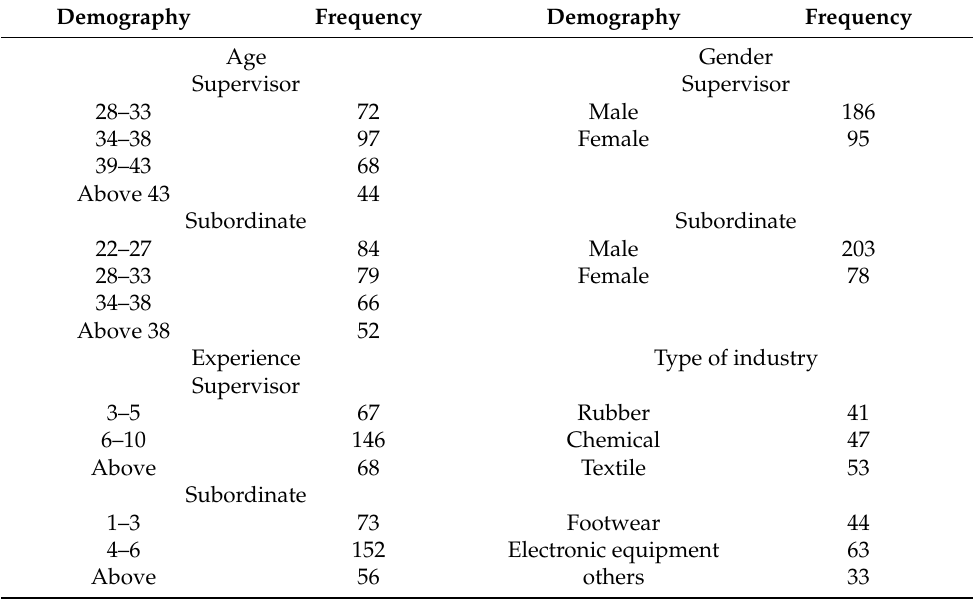
Table 1. Demographic of the respondents ( n =